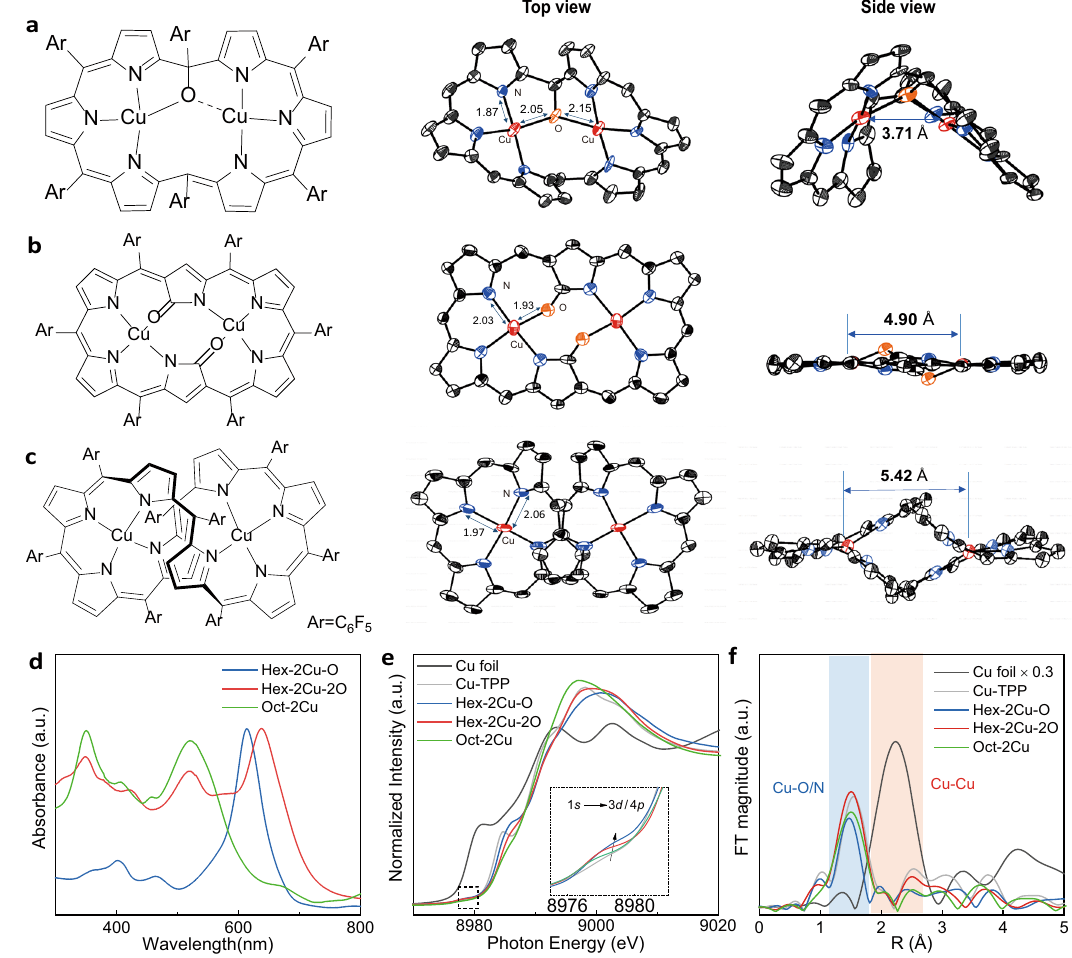
Fig. 1 | Structure and characterization of the bicentric expanded-porphyrin complexes. a – c Molecular structure and spatial geometry of Hex-2Cu-O ( a ), Hex- 2Cu-2O( b ),andOct-2Cu( c ). d UV –